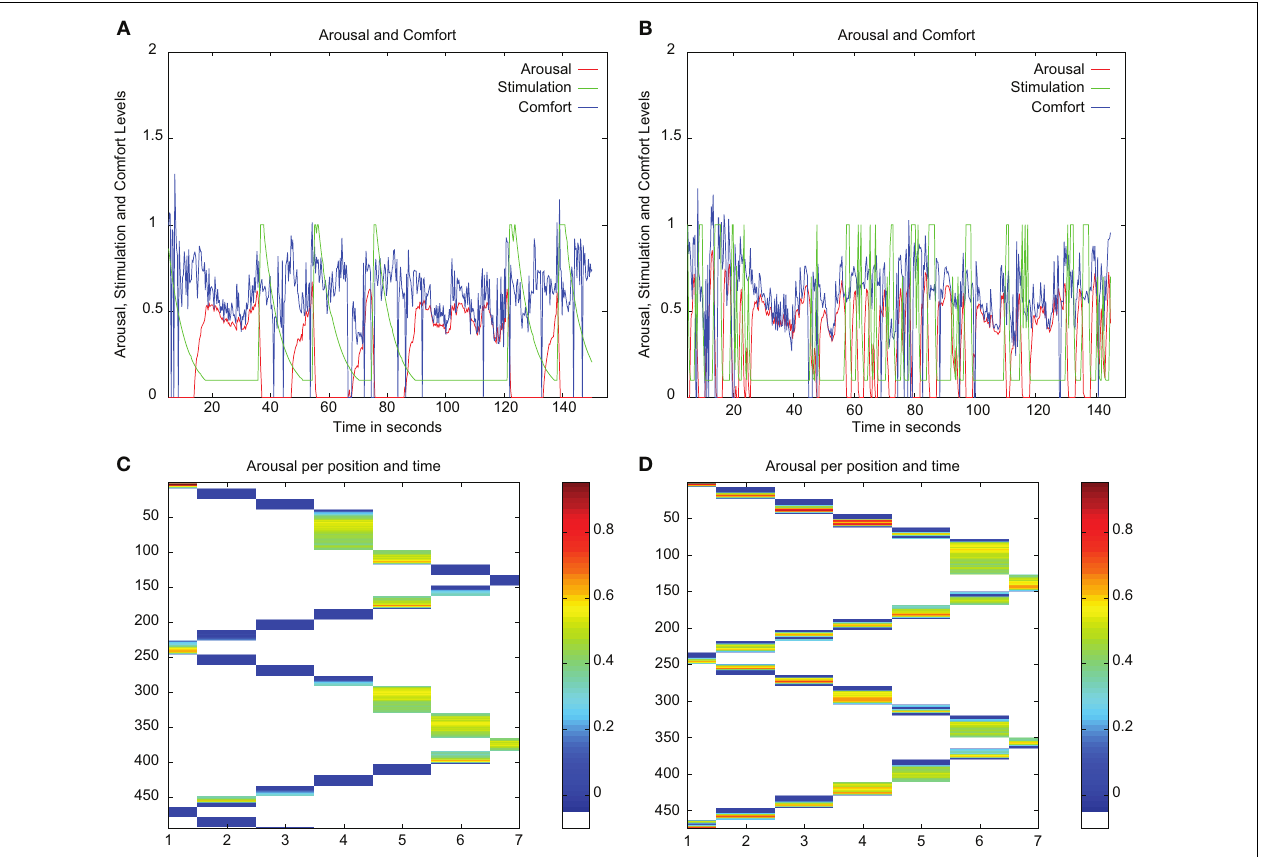
FIGURE 6 | Summary of the main variables of the architecture from experimental runs in the simple environment for both profiles of the robot. Panels (A,B) display show the arousal variations and the variables used to compute the arousal level. Panels (C,D) show the arousal of the robot against time for each position that the robot can reach in the environment. (A) Evolution of the Arousal (red), Comfort (green), and Stimulation (blue) for